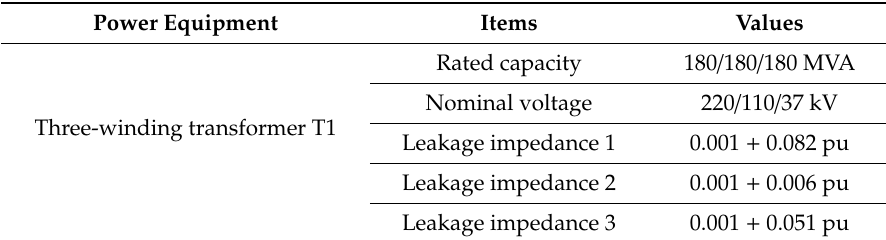
Table 2. Parameters of transformers and transmission